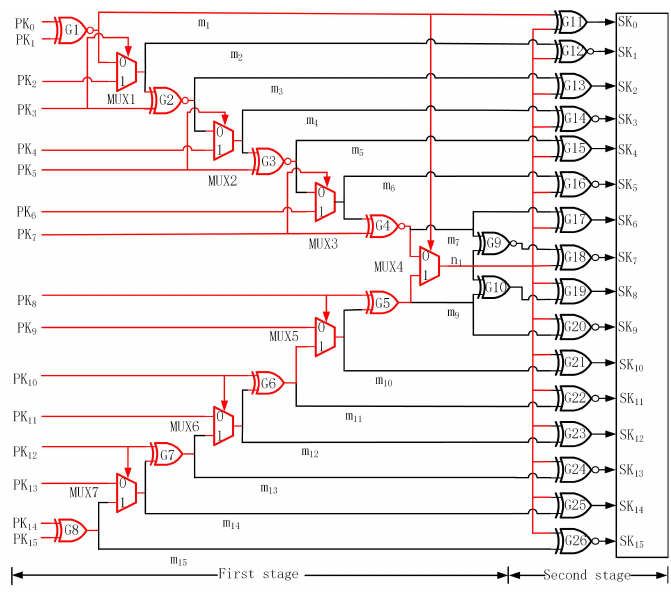
Figure 4. Proposed key interdependency block with 16